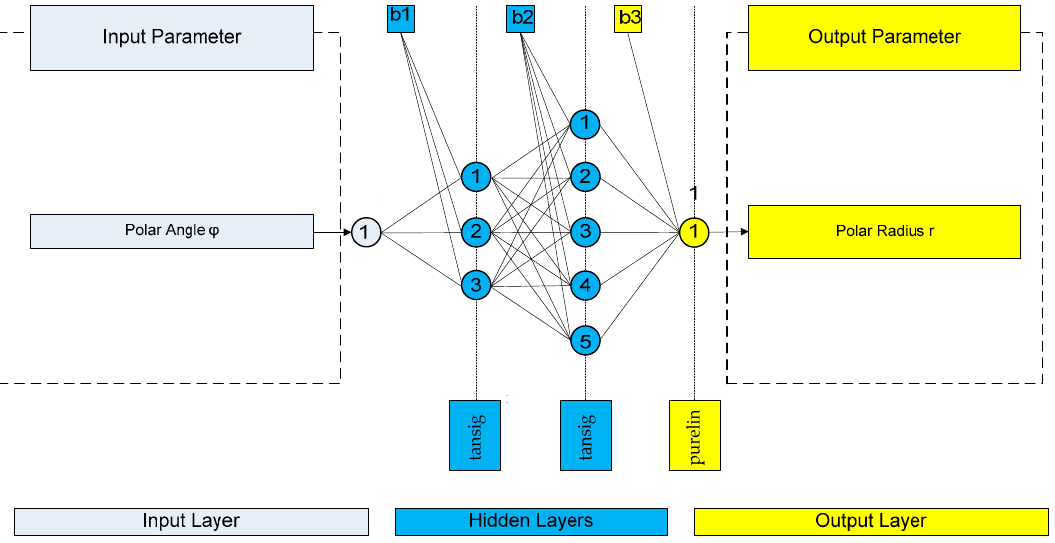
Appl. Sci. 2019 , 9 , x FOR PEER REVIEW Figure 11. Architecture of the optimum 1-3-5-1 BPNN model. Figure 11. Architecture of the optimum 1-3-5-1 BPNN model.